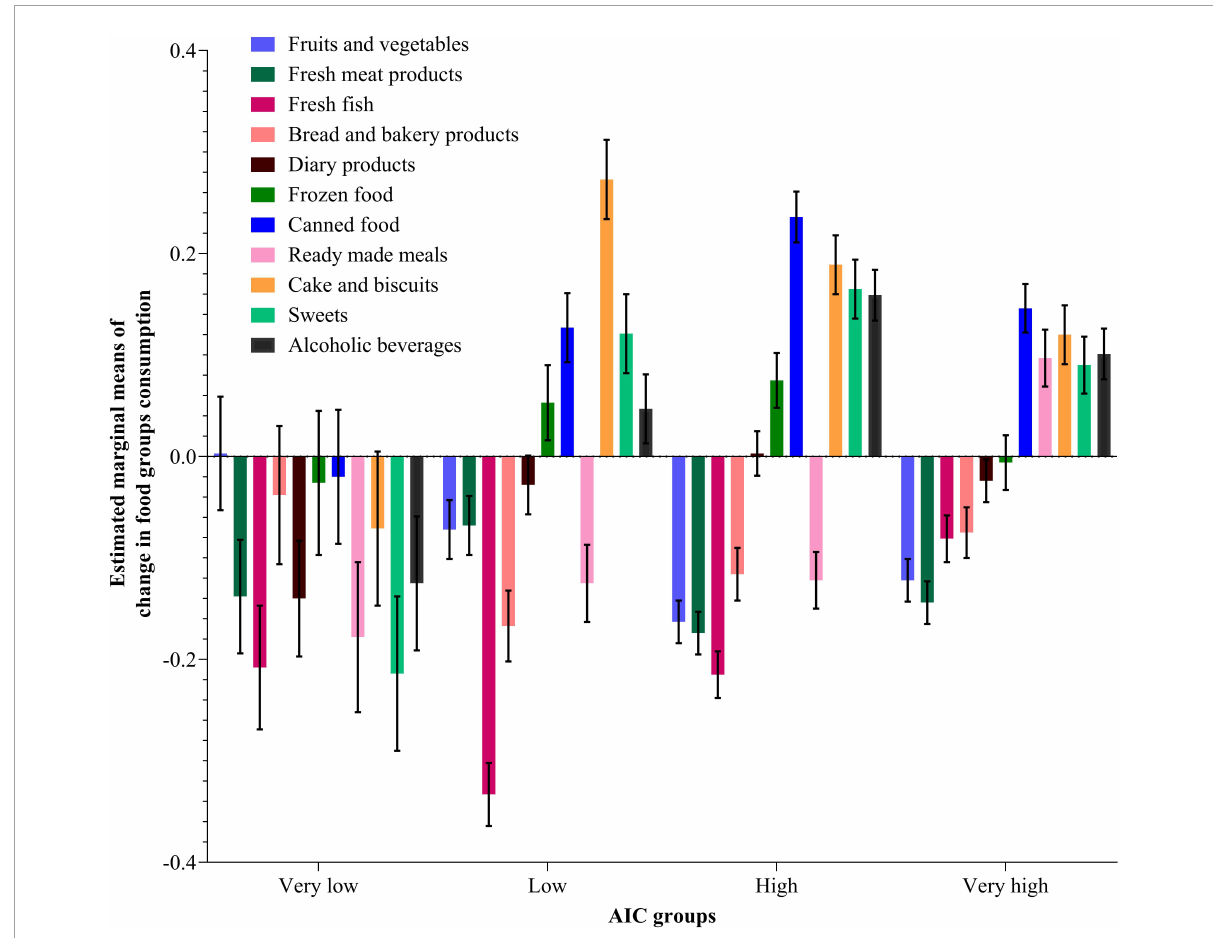
FIGURE2 Estimated marginal means using the MANOVA procedure for different food types consumption change (During—Before COVID-19) per AIC groups. Data weighted by countries (see also Supplementary Tables 2, 4